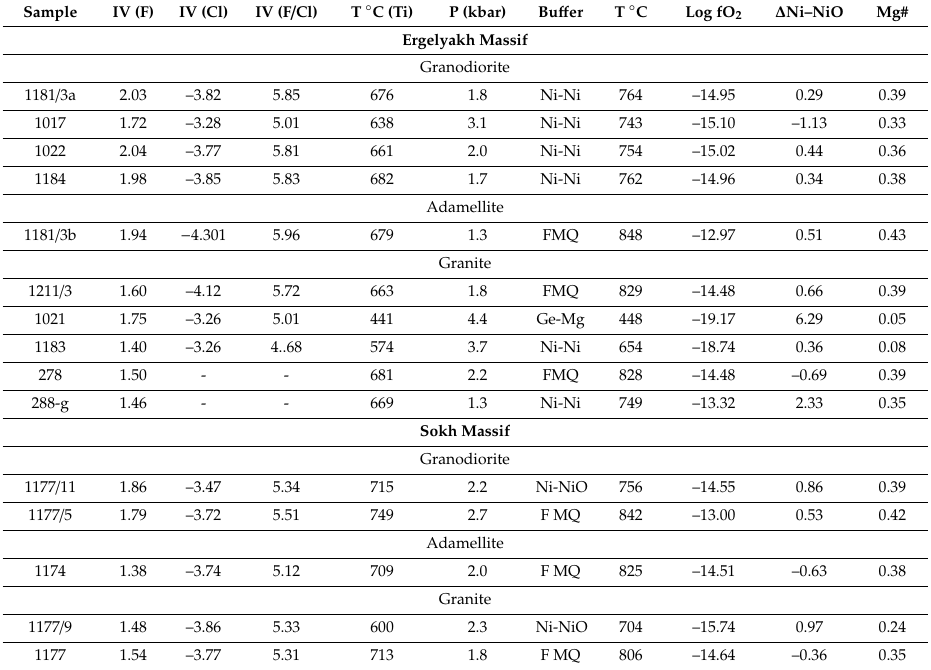
Table 11. Parameters of biotite formation from EIRGD granitoids.